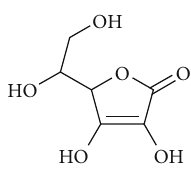
Scheme 1: The chemical structure of ascorbic acid.